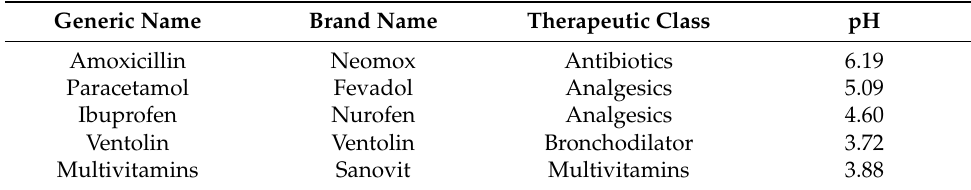
Table 1. Pediatric liquid drugs used in this study.